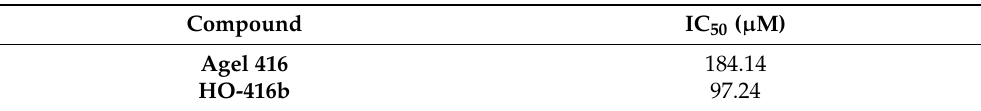
Figure 5. Viability of MCF-12A cells following treatments with PATs HO-416b and Agel 416 . Table 2. The IC 50 values of PATs HO-416b and Agel 416 in MCF-12A normal epithelial mammary